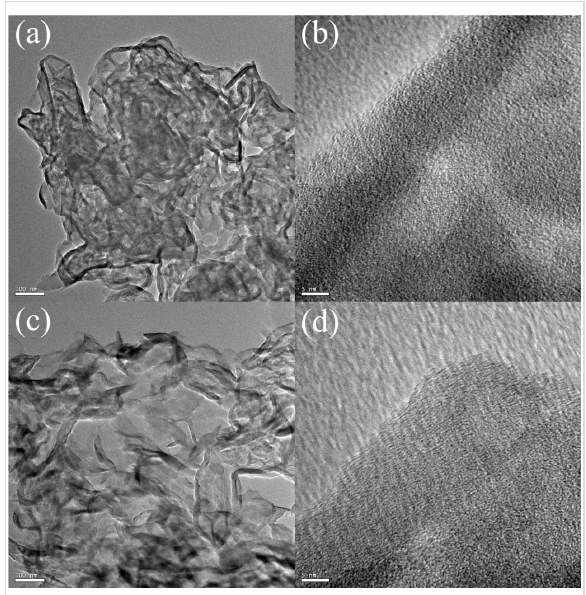
Figure 7: TEM and HR − TEM images of (a, b) MgO@g-C 3 N 4 and (c, d) g-C 3 N 4